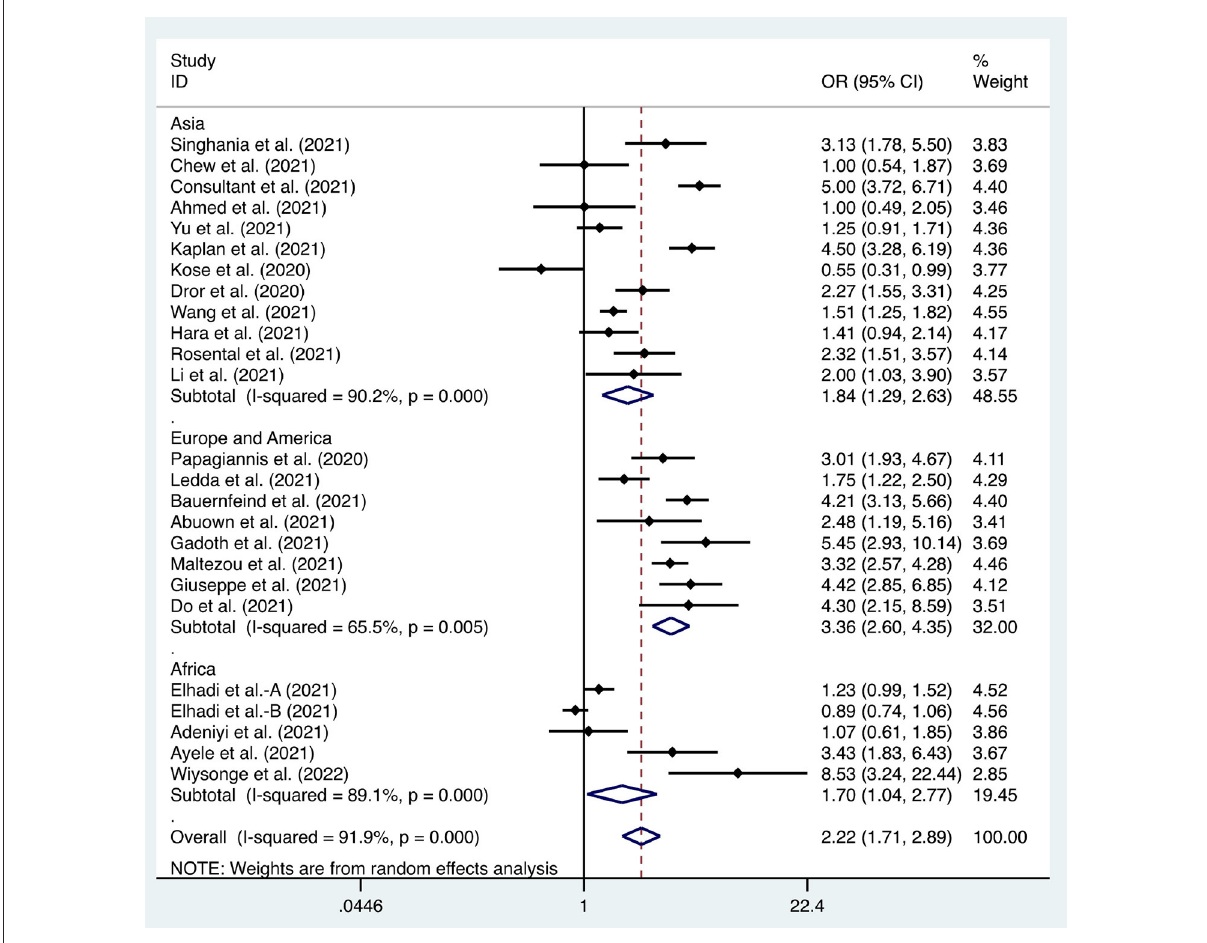
FIGURE4 Forest plot of the difference in the willingness between doctors and nurses to receive coronavirus disease 2019 vaccines.